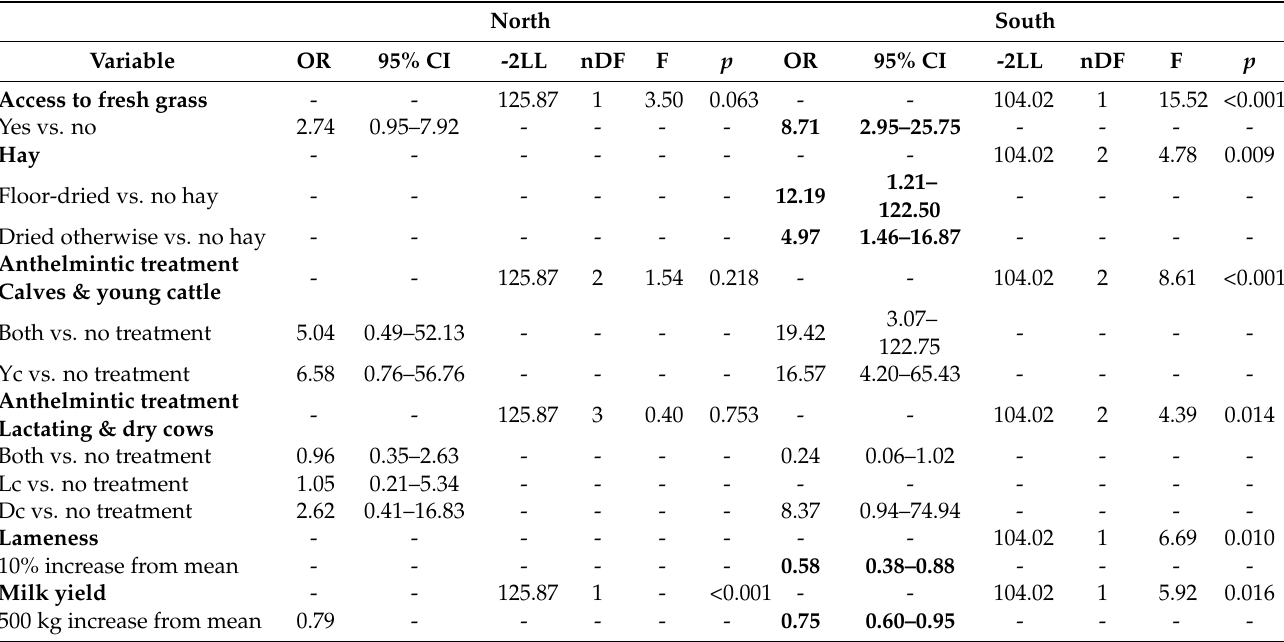
Table 4. Results from multivariate logistic models investigating the influence of predictor variables on F. hepatica BTM ELISA results (North: Df = 175; South: Df = 186). Significant ORs and CIs are printed in